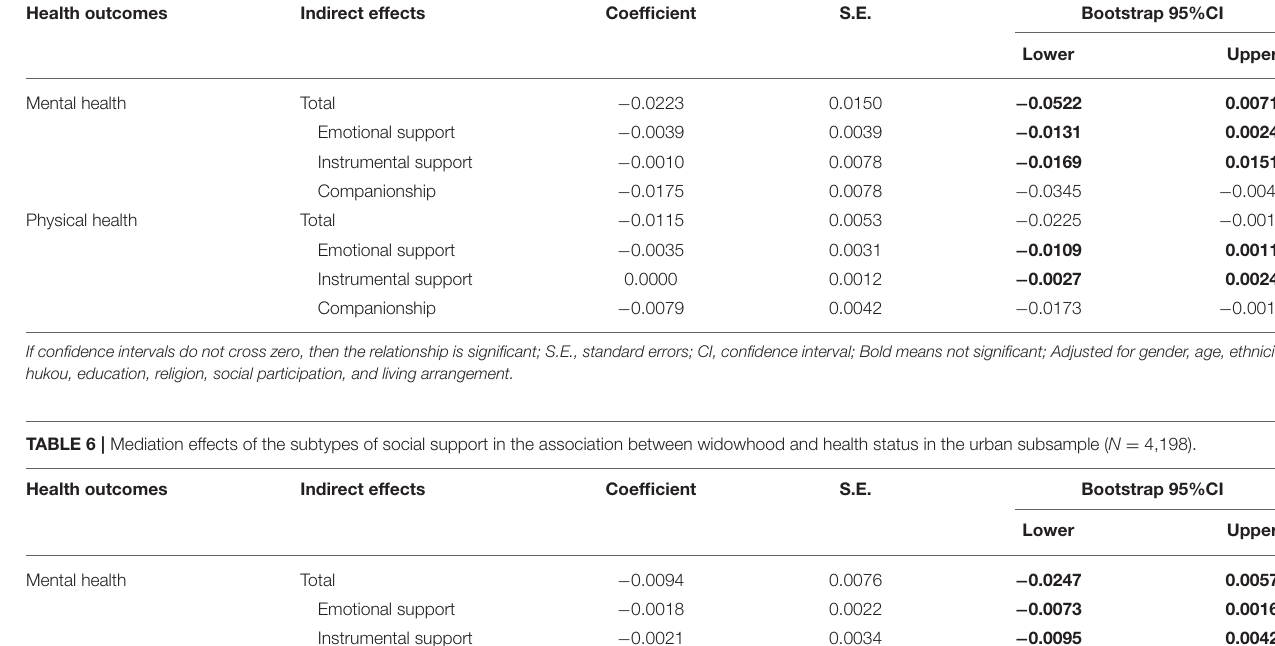
TABLE 5 | Mediation effects of the subtypes of social support in the association between widowhood and health status in the rural subsample ( N = 3,449). Health outcomes